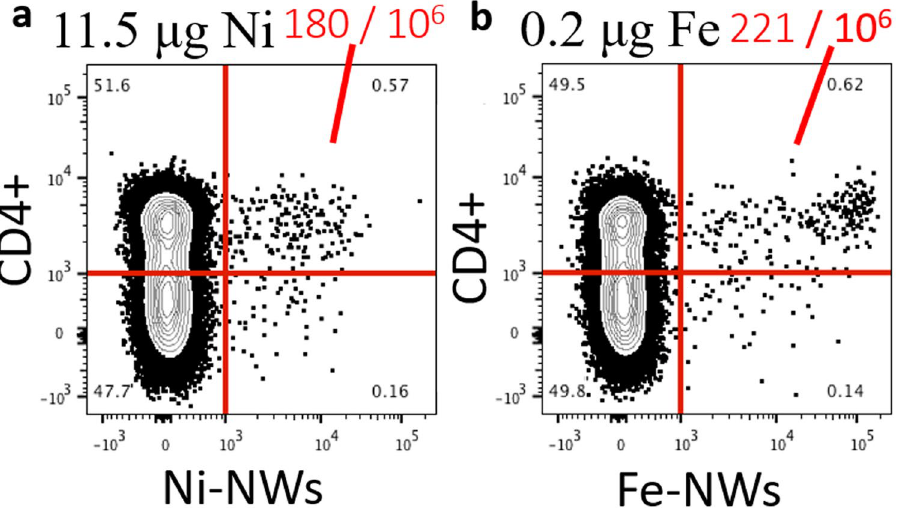
Figure 3. Flow cytometric analysis of CD4 + T lymphocytes cell suspensions after tagging and magnetic enrichment with fluorescent Ni (left) or Fe (right) nanowire conjugates and magnetic